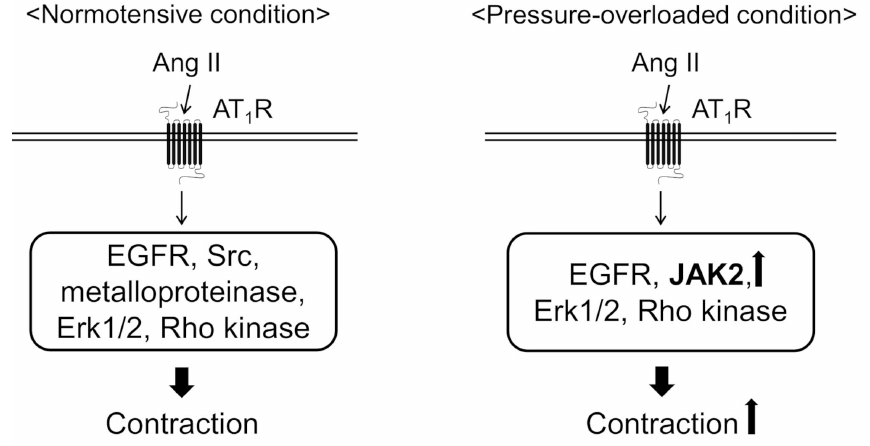
Figure 3. Proposed mechanisms underlying angiotensin II (Ang II)-induced aortic contraction in normotensive or pressure-overloaded condition. In normotensive condition, Ang II induces aortic contraction via epidermal growth factor receptor (EGFR), Src, metalloproteinase, extracellular signal- regulated kinase 1 and 2 (Erk1/2), and Rho kinase. In pressure-overloaded condition, Ang II induces aortic contraction via EGFR, Erk1/2, Rho kinase, and Janus kinase 2 (JAK2). Moreover, Ang II- induced aortic contraction is augmented in pressure-overloaded condition probably because the protein expression of JAK2 and myosin phosphatase targeting subunit 1 is increased. AT 1 R, Ang II type 1